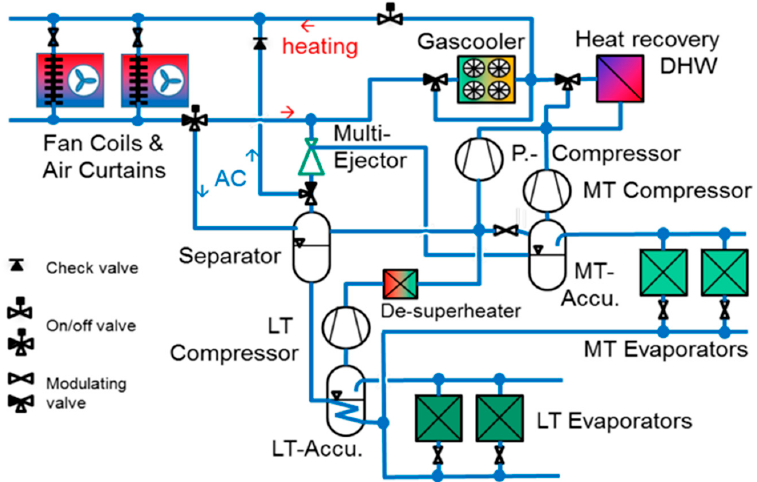
Figure 9. Integration of direct heating and cooling fan coils and air curtains in a transcritical R744 supermarket refrigeration system (ejectors employed in AC mode as well) [40].